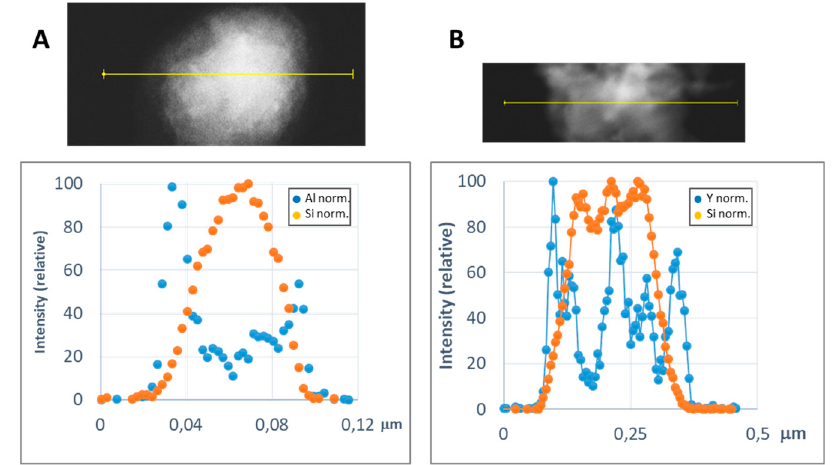
Figure 9. Representative line scans of the M x O m @SiC core–shell NPs (lab synthesis) (STEM-EDX, line scan tool): ( A ) Al 2 O 3 @SiC and ( B ) Y 2 O 3 @SiC. The upper part corresponds to the direct electron image